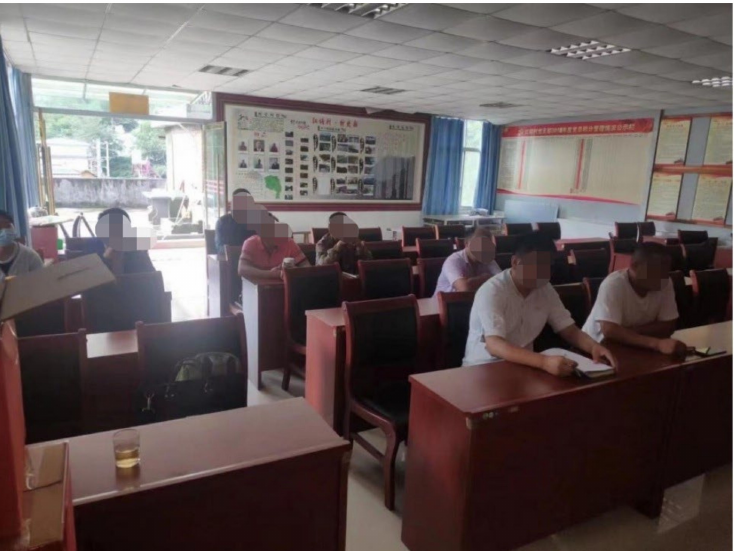
Figure 5. The public consultation meeting among multiple stakeholders before taking action. Source: the authors, taken in August 2022.